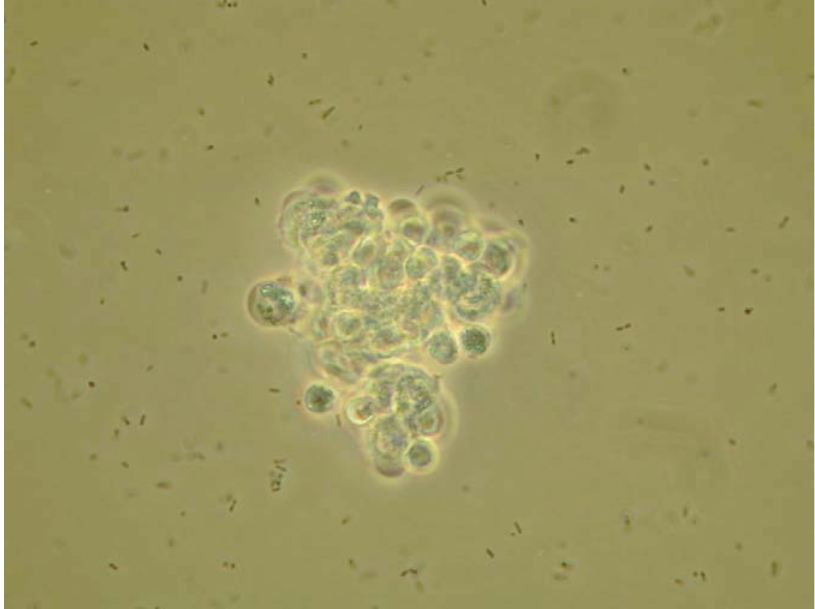
Figure 1. A microaggregate of hemocytes (approximately 10–12 (cid:2) m) formed at 1 h after injecting S. marcescens into the hemocoel of a tobacco hornworm. For this microphotograph (taken 1 h after injection), hemolymph was withdrawn, diluted with buffer and placed on a microscope slide for observation and photography. The cells in these photographs range from 10–12 microns. Photo by JSM.